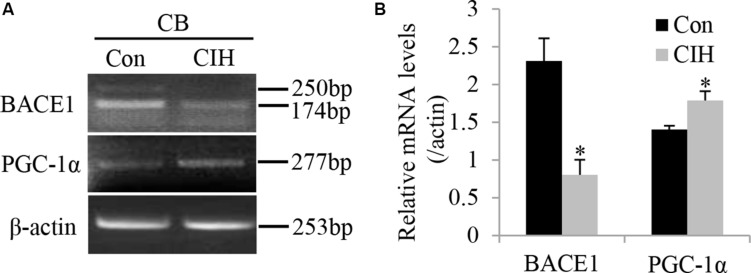
CIH treatment decreases the BACE1 mRNA level and increases the PGC-1α mRNA level. (A) RT-PCR showed expression of mRNAs of BACE1 and PGC-1α in rat CB taken from Control (Con, left lane) and CIH (right lane) group rats. (B) Statistical analysis of BACE1 and PGC-1α mRNA expression in rat CB after CIH treatment. The data were presented as means ± S.D. CIH: cyclic intermittent hypoxia. n = 8 in each group, *P < 0.05.